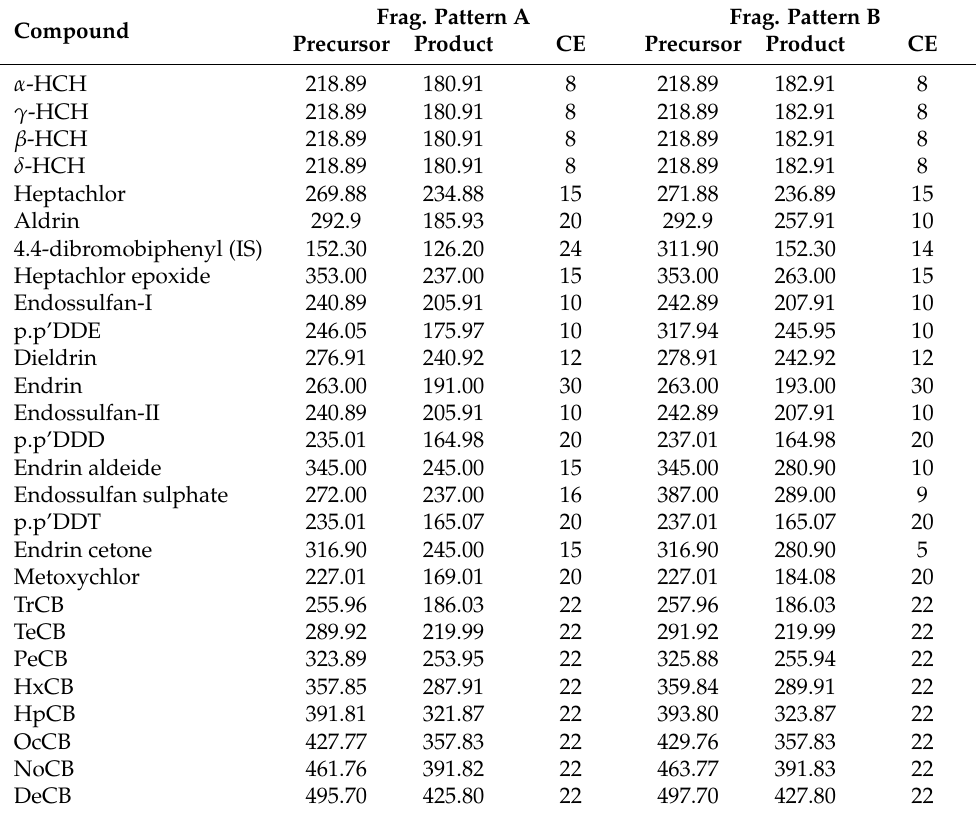
Table 2. Precursor and product ions (A and B patterns) for tandem mass spectrometry in the SRM mode. The PCB nomenclature [31] reflects their chlorination